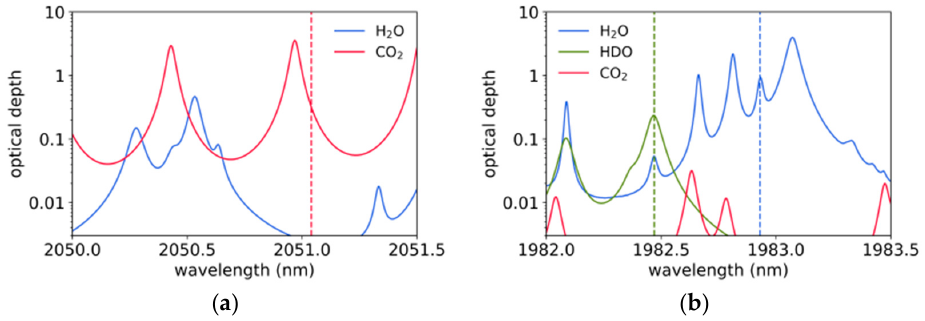
Figure 1. Optical depth for a vertical line of sight in the lowest 6 km of the atmosphere in the 2.05 µm range for CO 2 sounding ( a ) and the 1.98 µm range for H 2 O/HDO sounding ( b ). US Standard Atmosphere with 370 ppmv of CO 2 , 8500 ppmv of water vapor (at ground level, HDO relative abundance of 0.03%). Dashed lines indicate on-line wavelengths for DIAL measurement— calculations based on-line parameters from HITRAN 2016 database.